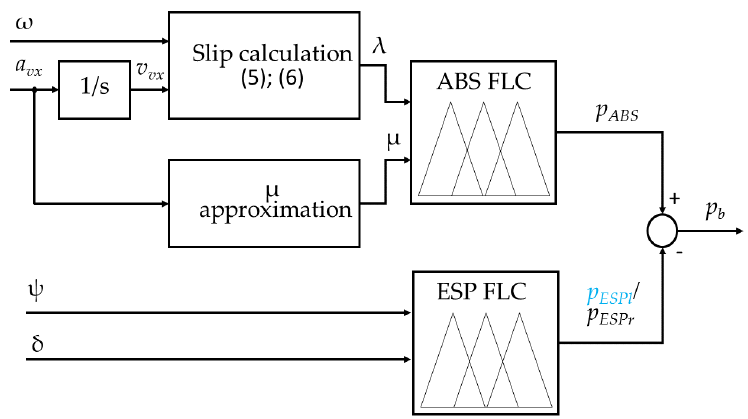
Figure 4. Controller block scheme for a single wheel: ABS FLC—anti-lock braking system fuzzy logic controller, ESP FLC—electronic stability program fuzzy logic controller, 1/s—integrational operation.